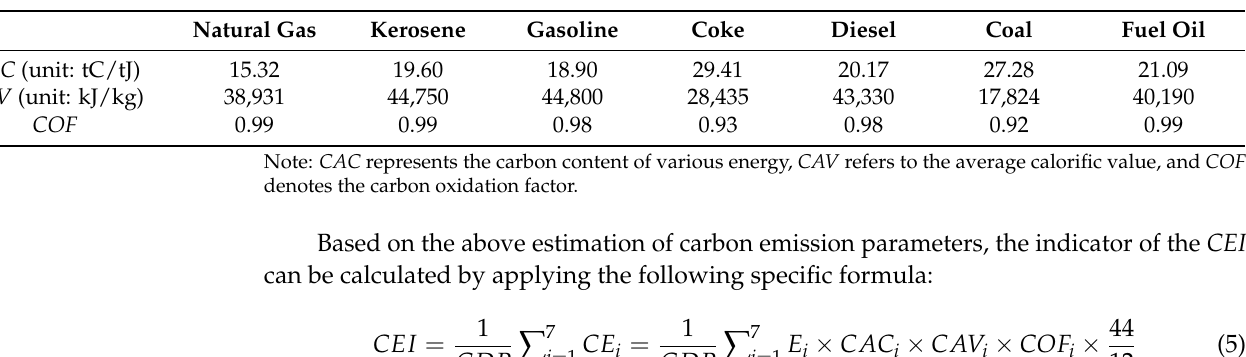
Table 2. The carbon emissions parameters of major energy